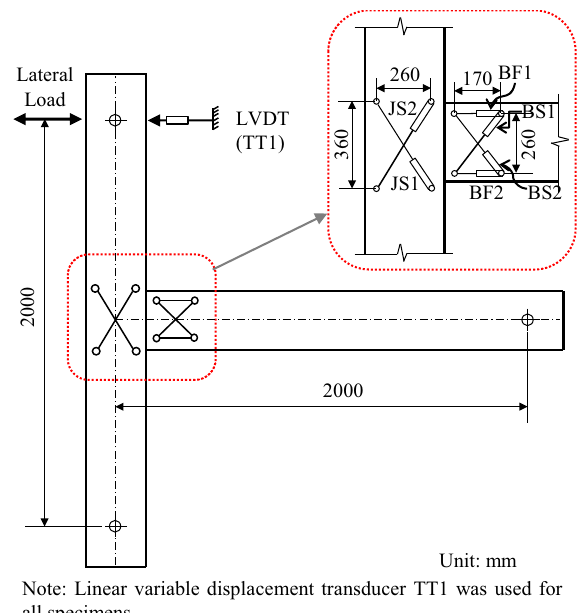
Fig. 12 Location of LVDTs in control